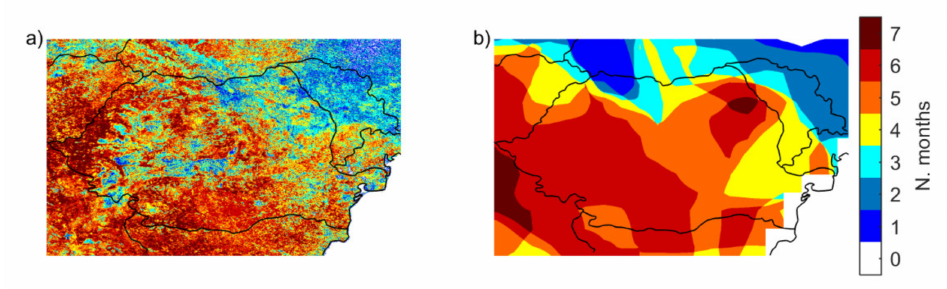
Figure 6. ( a ) Persistence, in moths, of NDVI anomalies below − 0.025; ( b ) duration of the drought event, in months, as assessed by SPEI with the time scale of 6 months.